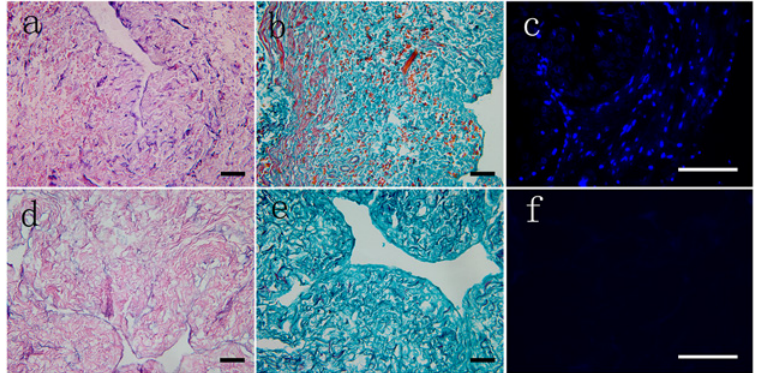
Fig 1. Histological analysis of fresh ureter tissue and its corresponding decellularized ECM via H&E, Masson ’ s trichrome and DAPI staining. Cellular debris was obvious in the fresh tissue cross-sections (a, b) but had disappeared in the decellularized ECM (d, e). Intact and well-organized nuclei could be observed in the fresh tissue (c), whereas none could be seen in the decellularized ECM (f). Inset scale bar = 300 μ m.